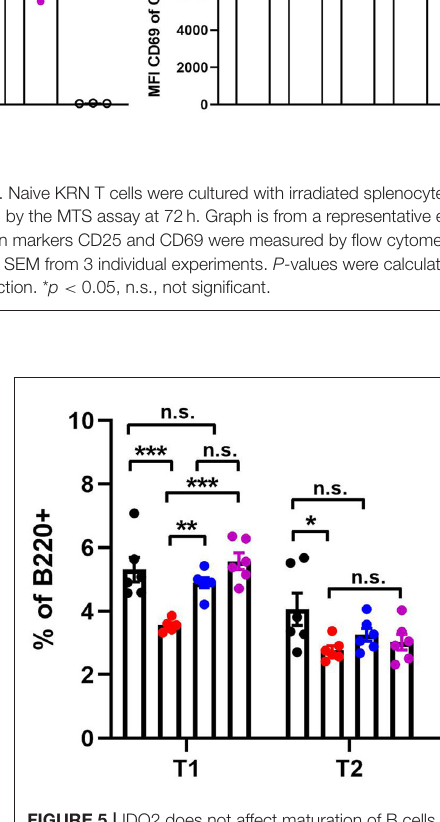
FIGURE 5 | IDO2 does not affect maturation of B cells in the spleen. The frequency of transitional B cell subsets in wt, IDO1 ko, IDO2 ko, and dko spleens were measured by flow cytometry. Transitional B cell subpopulations were defined as T1 (B220 + CD93 + IgM hi CD23 − ), T2 (B220 + CD93 + IgM hi CD23 + ), and T3 (B220 + CD93 + IgM low CD23 + ). Symbols represent individual mice and histograms show the mean percentage out of total B cells ± SEM from 6 mice per genotype in 2 independent experiments. P -values were calculated by one way-ANOVA followed by comparison of means with Tukey’s post-hoc multiple comparison correction. * p < 0.05, ** p < 0.01, *** p < 0.001, n.s., not